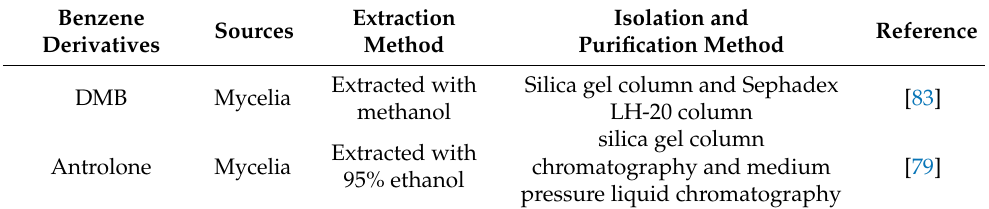
Table 5. Preparation procedures of benzene derivatives from A. cinnamomea in recent publications.